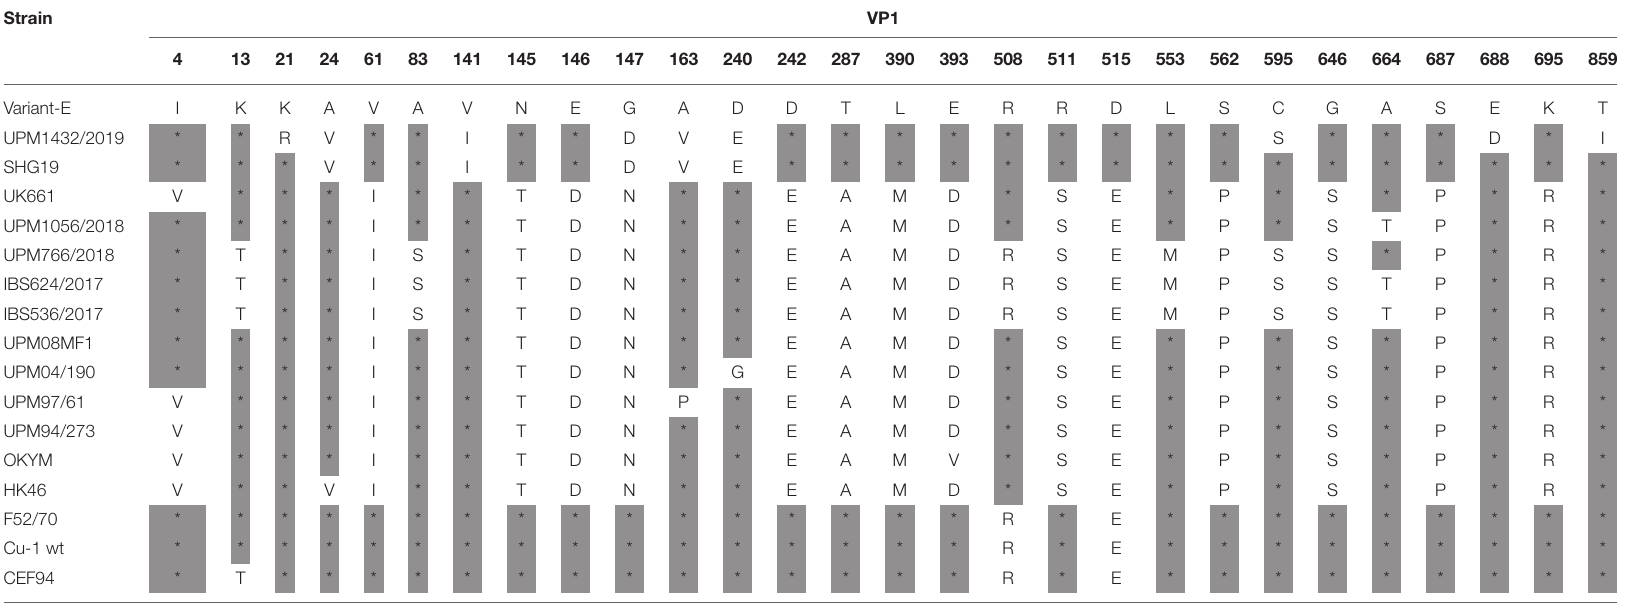
The gray area with asterisk indicate aa position identical to the reference strain, Variant